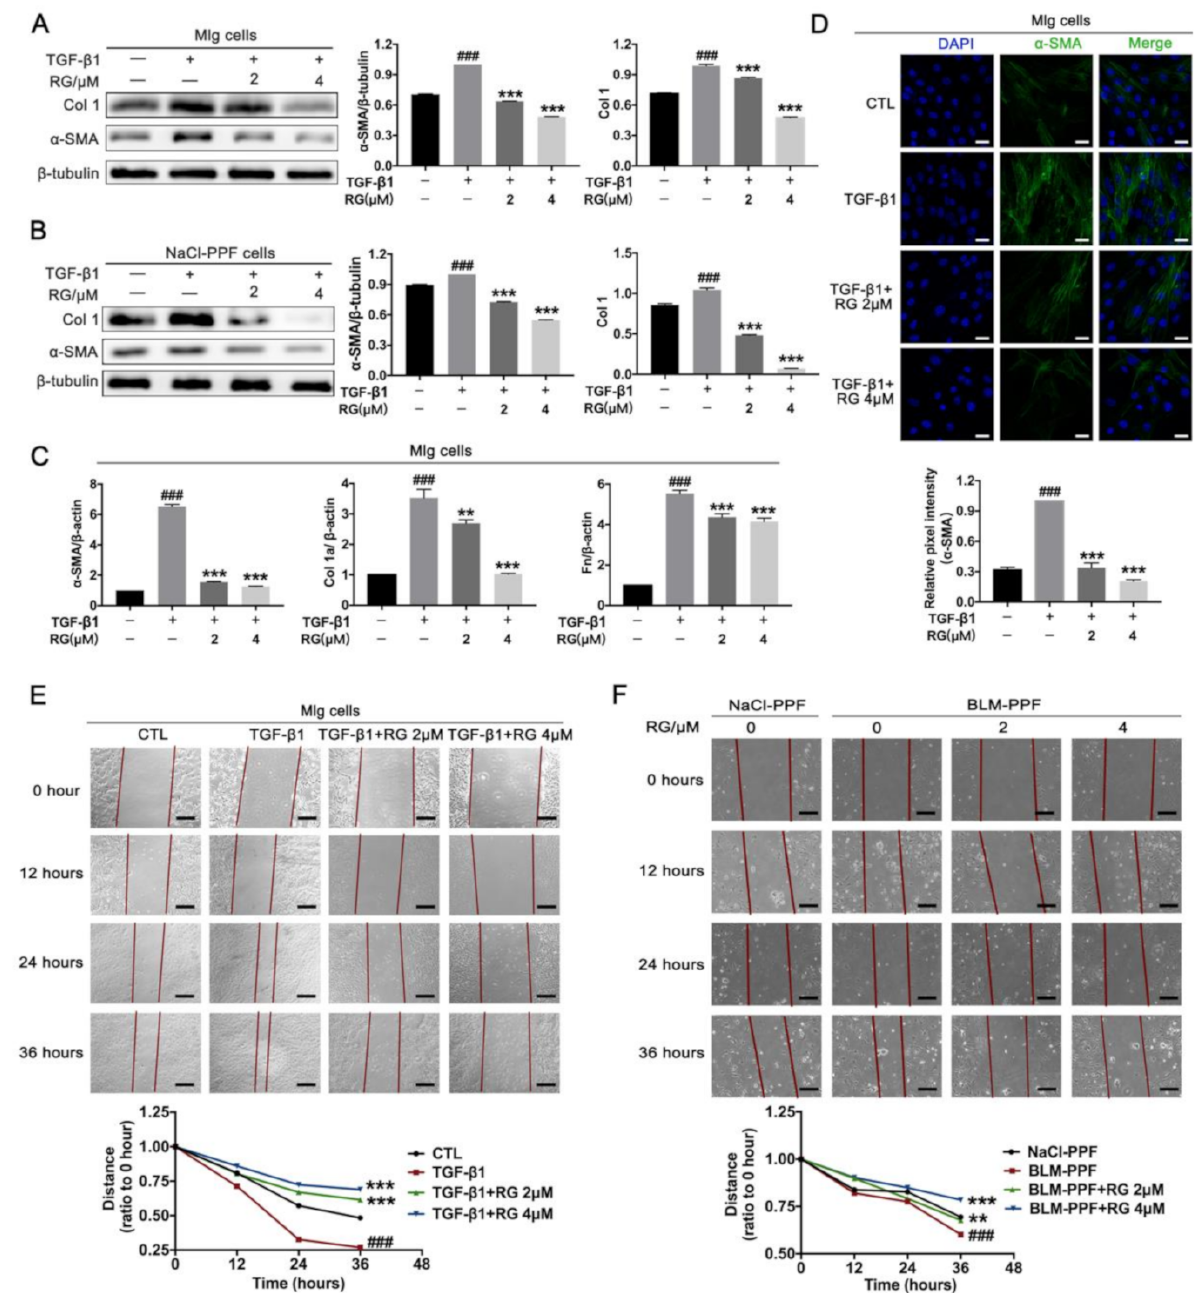
Figure 2. Regorafenib suppresses transforming growth factor (TGF)- β 1-induced activation, extracellular matrix (ECM) accumulation, and the migration of pulmonary fibroblasts. ( A , B ) Mouse lung fibroblast (Mlg) or NaCl-primary pulmonary fibroblast (PPF) cells were exposed to TGF- β 1(5 ng/mL) and/or regorafenib (RG) (2 µ M, 4 µ M) for 24 h to detect the expression levels of α -SMA and Col 1 by Western blotting. Densitometric analyses are shown; ( C ) Mlg cells were exposed to TGF- β 1 (5 ng/mL) and/or RG (2 µ M, 4 µ M) for 24 h, and quantitative real-time PCR was used to detect the mRNA levels of α -SMA, Col 1a, and Fn; ( D ) RG (2 µ M, 4 µ M) was exposed to Mlg cells for 24 h, and the α -SMA expression level was detected by immunofluorescence. Relative pixels intensity is shown. Scale bars: 50 µ m; ( E ) Mlg cells were treated with TGF- β 1 and/or RG (2 µ M, 4 µ M) for 0, 12, 24, or 36 h. Distance analyses are shown below. Scale bars: 100 µ m; ( F ) The PPF cells isolated from NaCl-treated and BLM-treated mice were incubated RG (2 µ M, 4 µ M) for a series of time points (0, 12, 24, 36 h). Distance analyses are shown below. Scale bars: 100 µ m; Data in ( A – F ) are means ± standard error of mean (SEM), and β -tubulin was used as a loading control. ### p < 0.001, ** p < 0.01, *** p < 0.001 (one-way ANOVA), NS: not